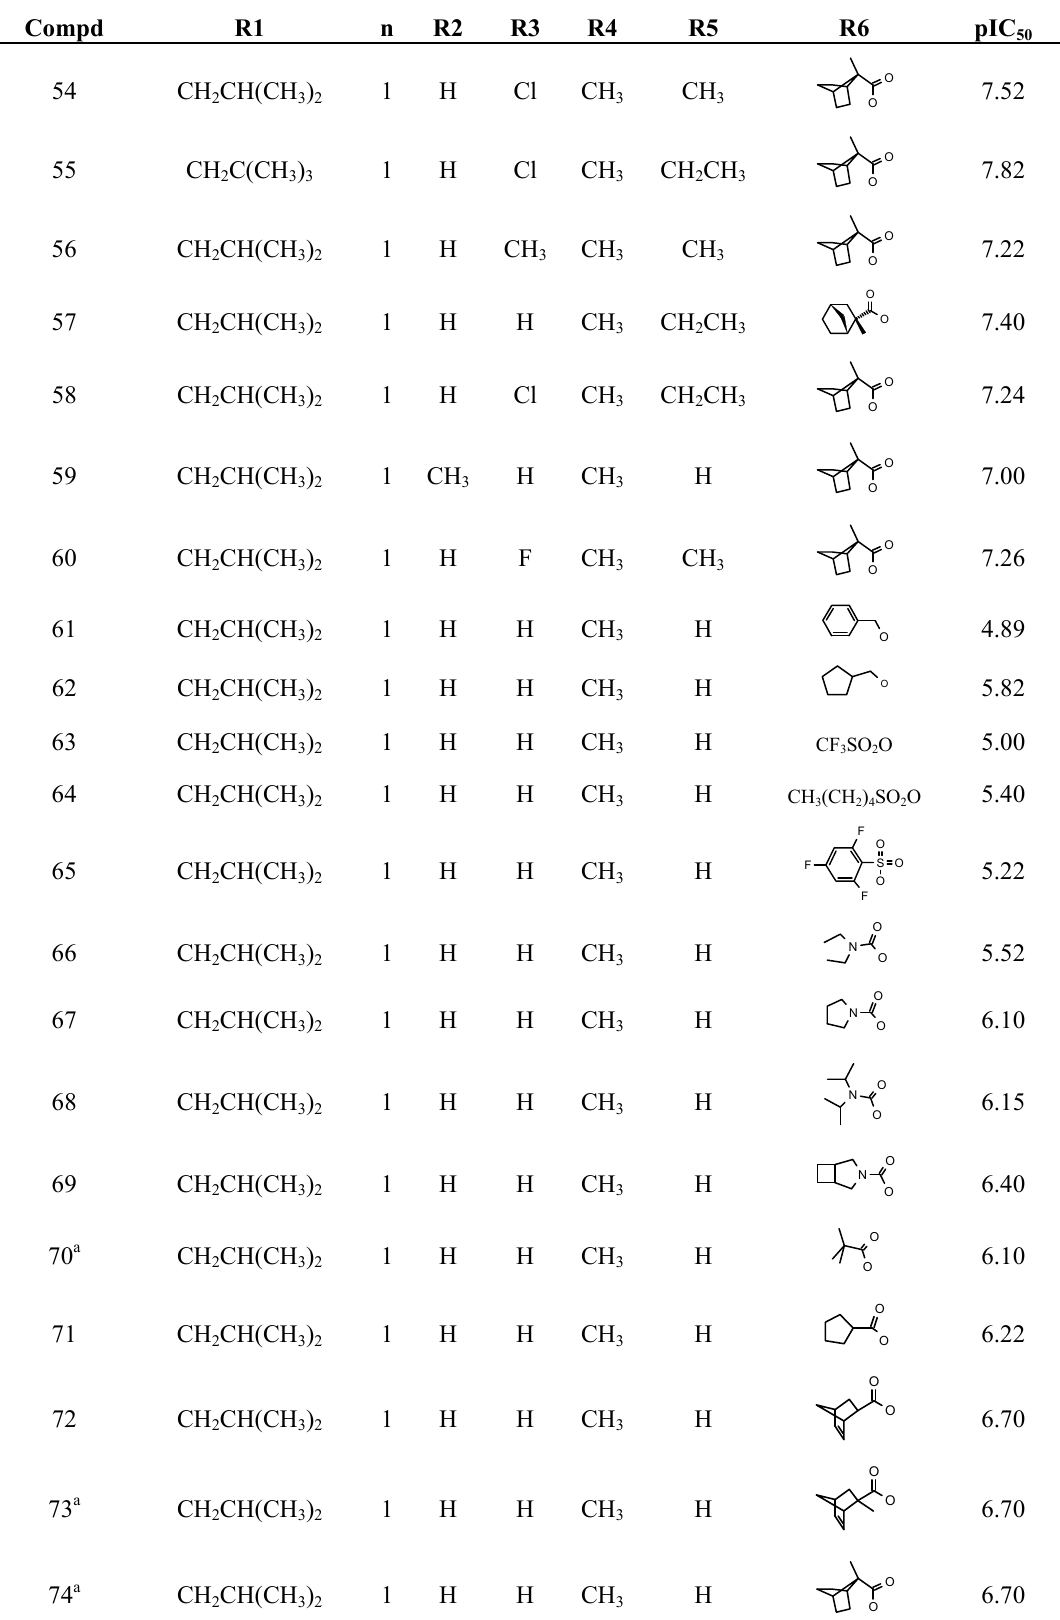
a Table note: these compounds are used as a test